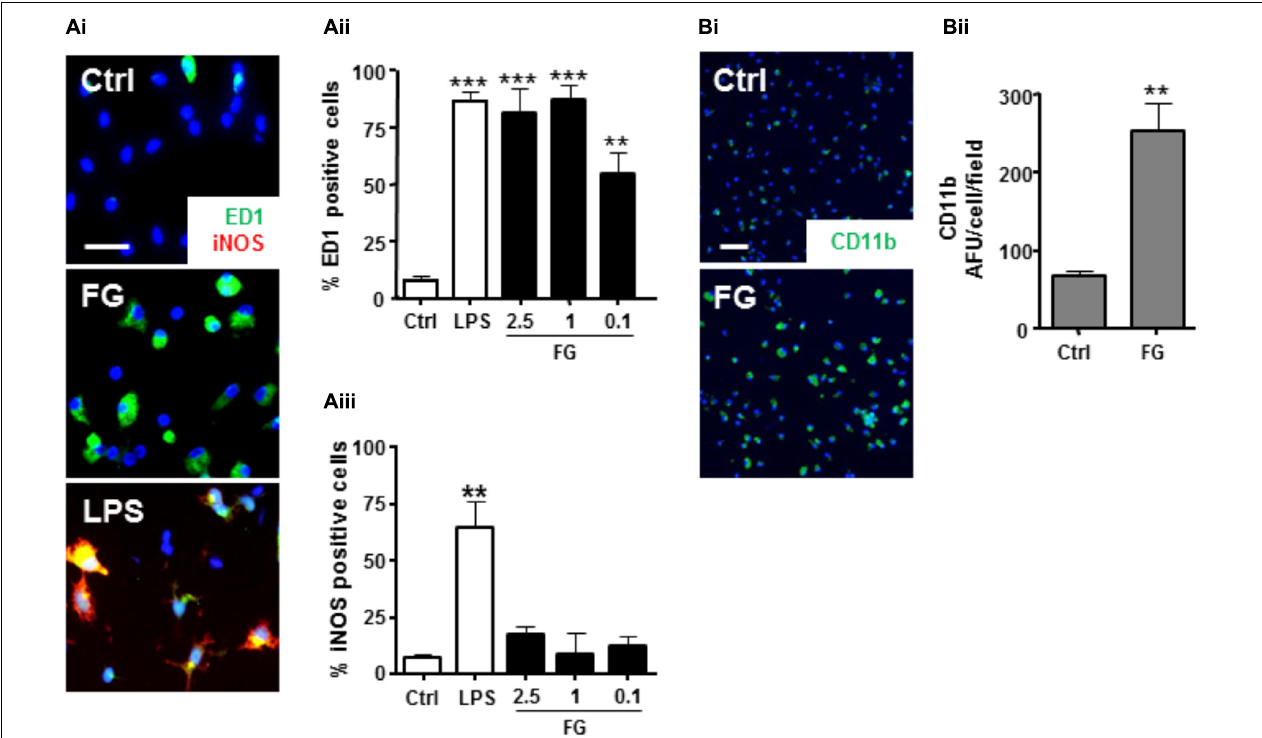
FIGURE 2 | FG induces microglial reactivity. (A) Control primary rat microglia (Ctrl) or microglia exposed to FG (2.5 mg/ml) or LPS (1 µ g/ml) for 24 h followed by immunocytochemistry for ED1 and iNOS (Scale bar: 30 µ m; Ai ), and nuclear co-staining with DAPI (blue), quantified as a % percentage of cells expressing ED1 (Aii) , or iNOS (Aiii) . (B) Immunofluorescence of surface CD11b staining in primary microglial cultures following 24 h of FG treatment (Scale bar: 60 µ m; Bi ) and nuclear co-staining with DAPI (blue), quantified as a % percentage of CD11b + cells, compared with control (Bii) . Data represent the mean ± SEM of 5 defined fields from at least three independent experiments. Significance levels are ∗∗∗ p < 0.001, ∗∗ p < 0.01 compared with relevant